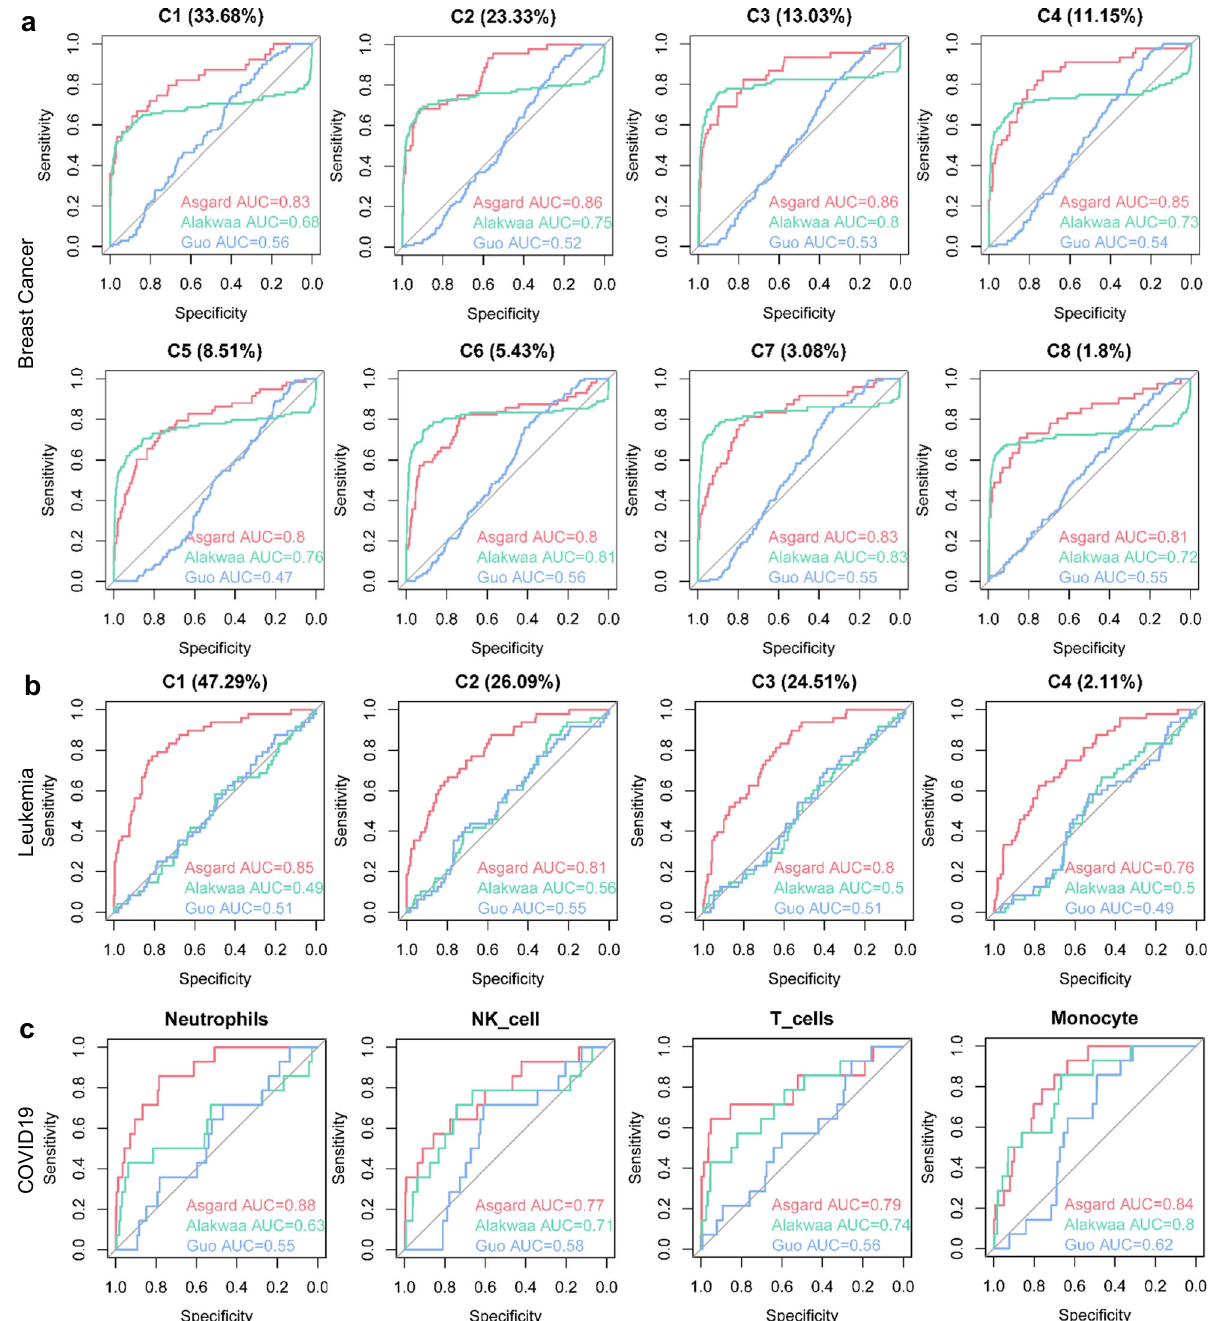
Fig. 3 | Comparing ASGARD to other single-cell-based repurposing methods. The receiver operating characteristic (ROC) curves and area under curve (AUC) scores of the ASGARD (red) and other published pipelines: Alakwaa ’ s pipeline (green) and Guo ’ s pipeline (blue). The results of drug/compound repurposing are shown on every cell cluster of the metastatic breast cancer dataset ( a ), every cell